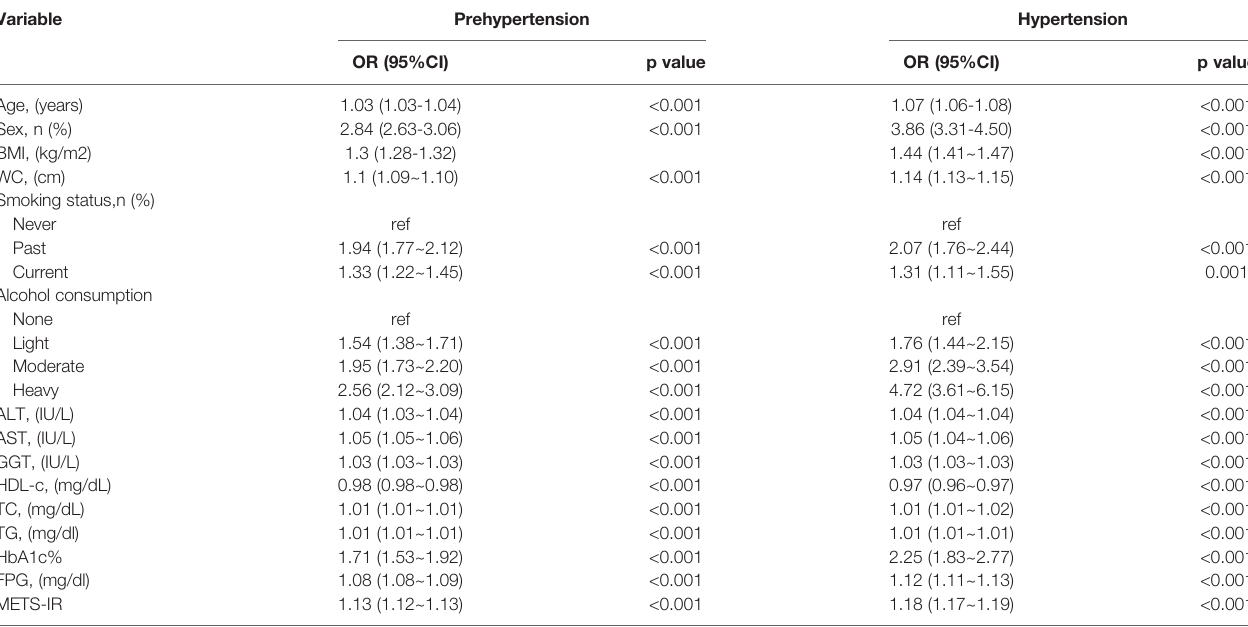
TABLE 2 | Results of univariate analysis of prehypertension and